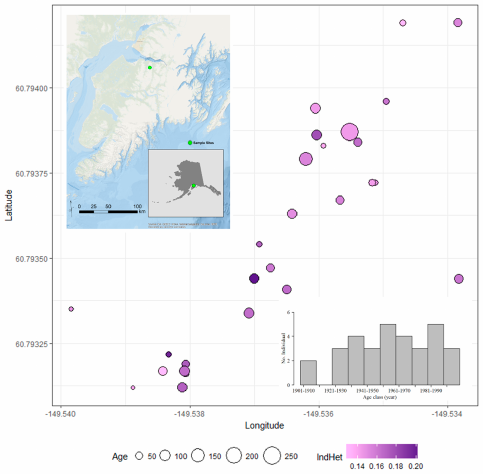
Figure 2. Inset map; Palmer Creek Drainage within the Chugach NF on the Kenai Peninsula, Alaska. The green points represents the study site both at the state scale and on the Peninsula. The transect map shows the geographic position of each tree on the sampled transect with circle size related to the age of the tree and the purple gradient representative of the level of individual observed heterozygosity (IndHet) measured at 4665 genome wide single nucleotide polymorphisms (SNPs); the darker the color purple, the more genomically diverse the individual (see Table 1 for IndHet values). Histogram inset: Age structure of Mountain Hemlock along the study transect representing the chronology length from 1900 to 2012.